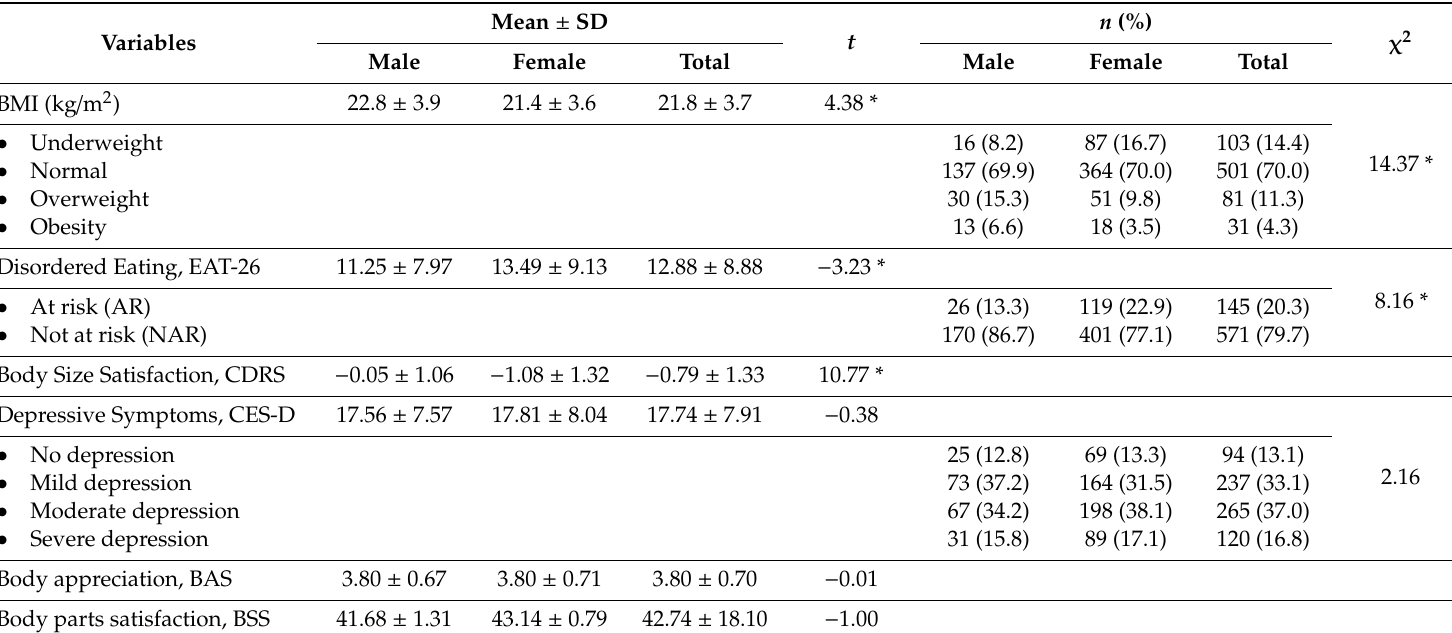
Table 2. Comparison of body mass index (BMI), disordered eating, body image perception, depressive symptoms, body appreciation, body image satisfaction, and self-esteem of university students according to sex ( n =